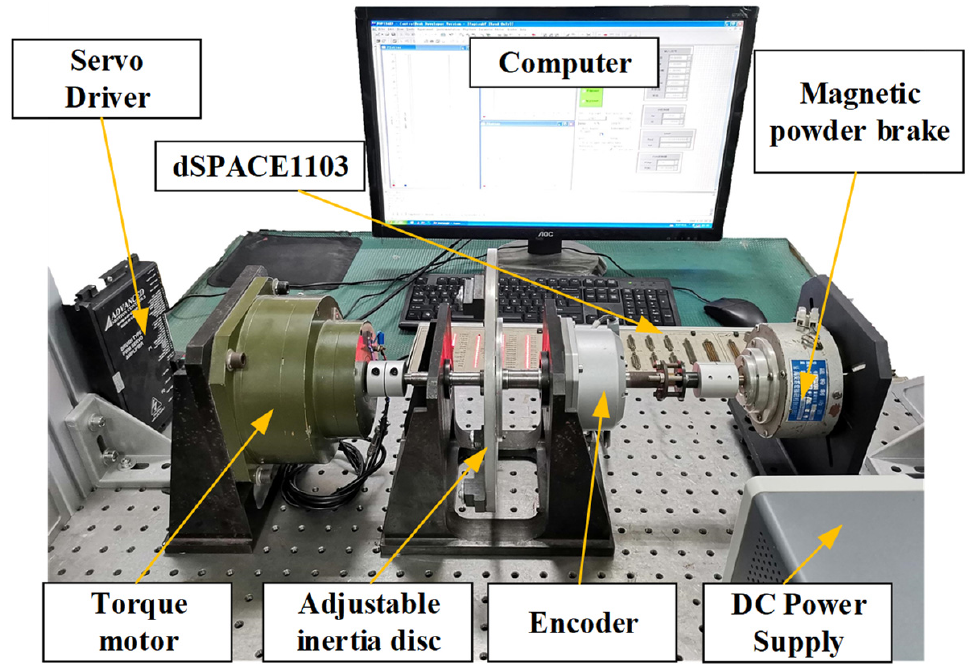
Figure 4. Experimental setup. Table 1. Parameters of the experimental device.